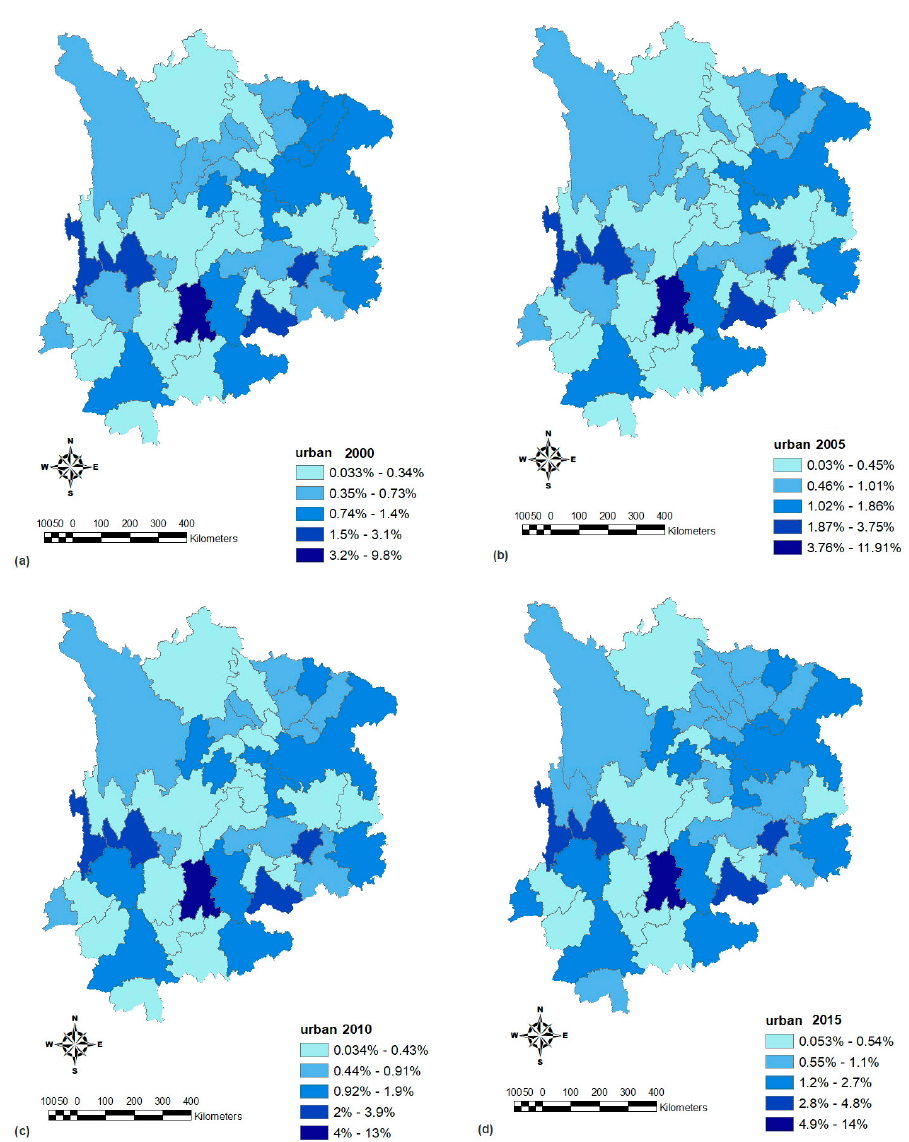
Figure 5. The proportion of urban land in di ff erent cities in four di ff erent years: ( a ) 2000; ( b ) 2005; ( c ) 2010; and ( d ) 2015.